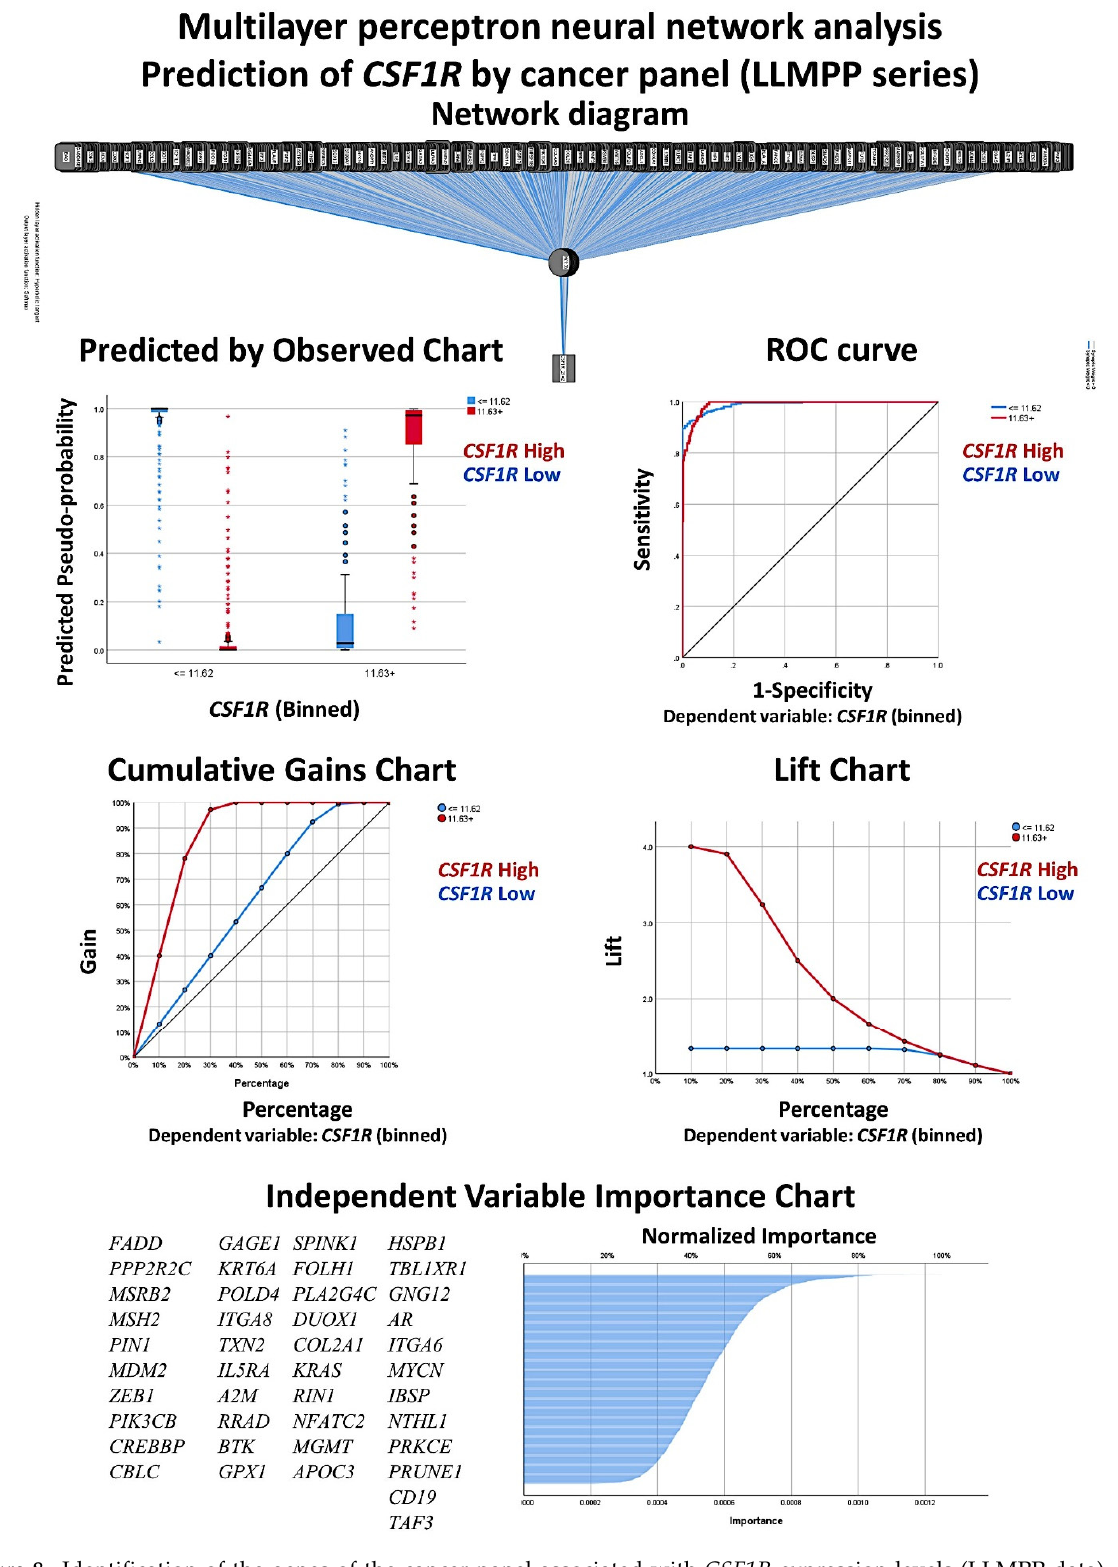
Figure 8. Identification of the genes of the cancer panel associated with CSF1R expression levels (LLMPP data). The multilayer perceptron neural network analysis was also performed using an immuno-oncology cancer panel of 1790 genes. In this analysis, the Receiver Operating Characteristic (ROC) area under the curve was 0.99. Therefore, these genes are highly associated and are capable of predicting the CSF1R expression with high accuracy.